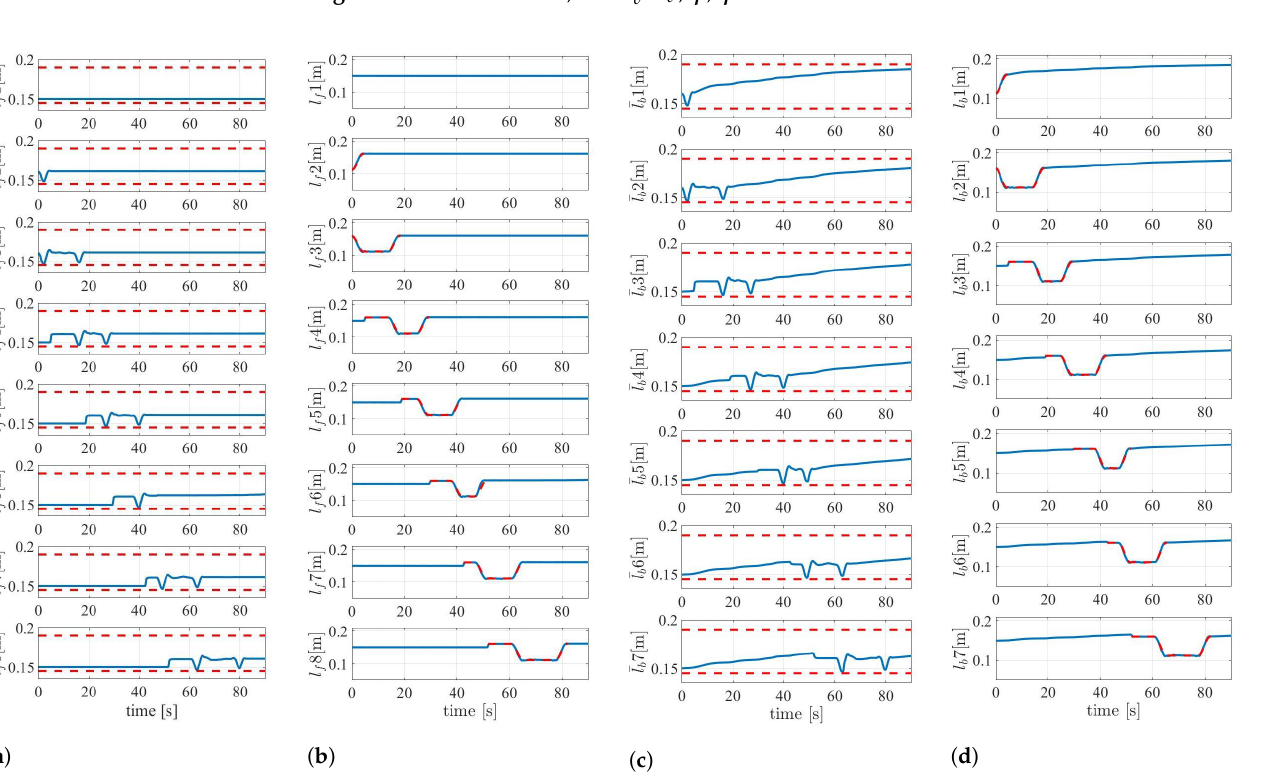
Figure 7. The results of w , det ˜ A (cid:62) σ ˜ A σ , φ , ψ .